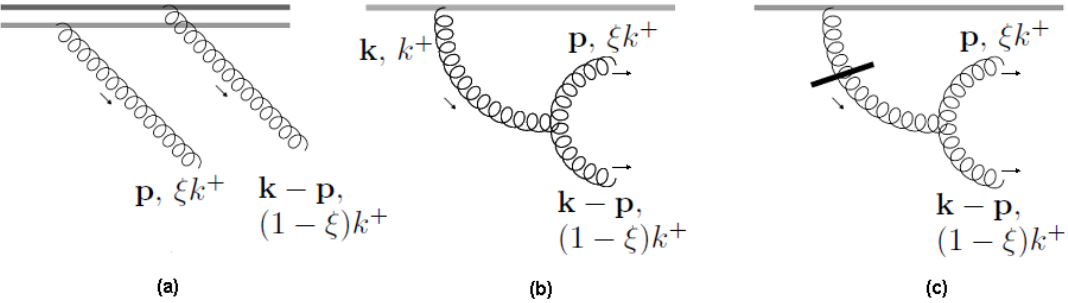
(cid:12) (cid:12) (cid:11) (cid:11) , (c) - (cid:12) 2 gg (cid:12) 3 gg